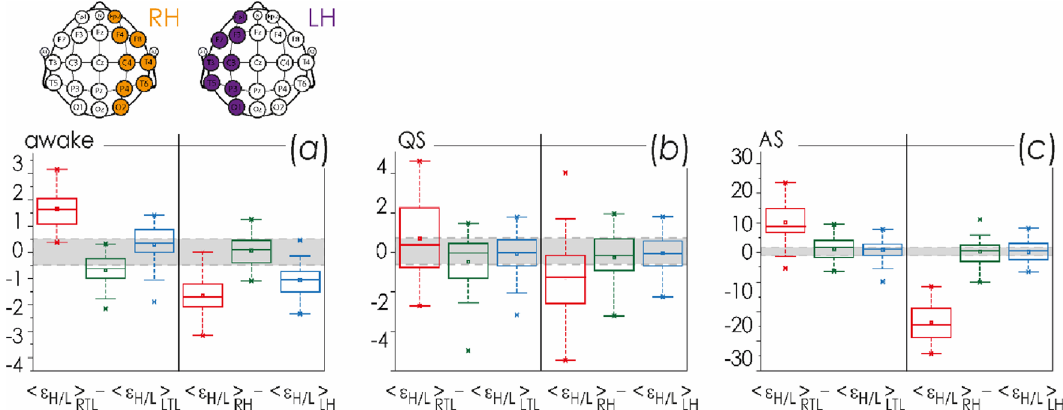
Figure 4. Distributions of the differences of integral energy ratios in the high frequency range to the low frequency range, (cid:31) ε H / L (cid:30) AW,AS,QS , between the right and left hemispheres, RH and LH: ( a ) diagrams for AW state; ( b ) diagrams for QS state; ( c ) diagrams for AS state. The localization of EEG channels on the scalp for each hemisphere is shown above. Red color indicates estimates for group II (EEG monitoring event GA34–37 10d ), green and blue colors code the estimates of the first and second monitoring events in group I, GA38–41 8h and GA38–41 10d , respectively. Gray color shows the difference range [− 0.5; 0.5], corresponding to minor activity differences between the right and left hemispheres. The diagrams depict the following statistical characteristics of numerical indicators: the first and the third quartiles (25–75%, inside the box), the median and the mean (transverse line and point inside the box, respectively), 1.5 interquartile ranges (shown by whiskers), and outliers represented by